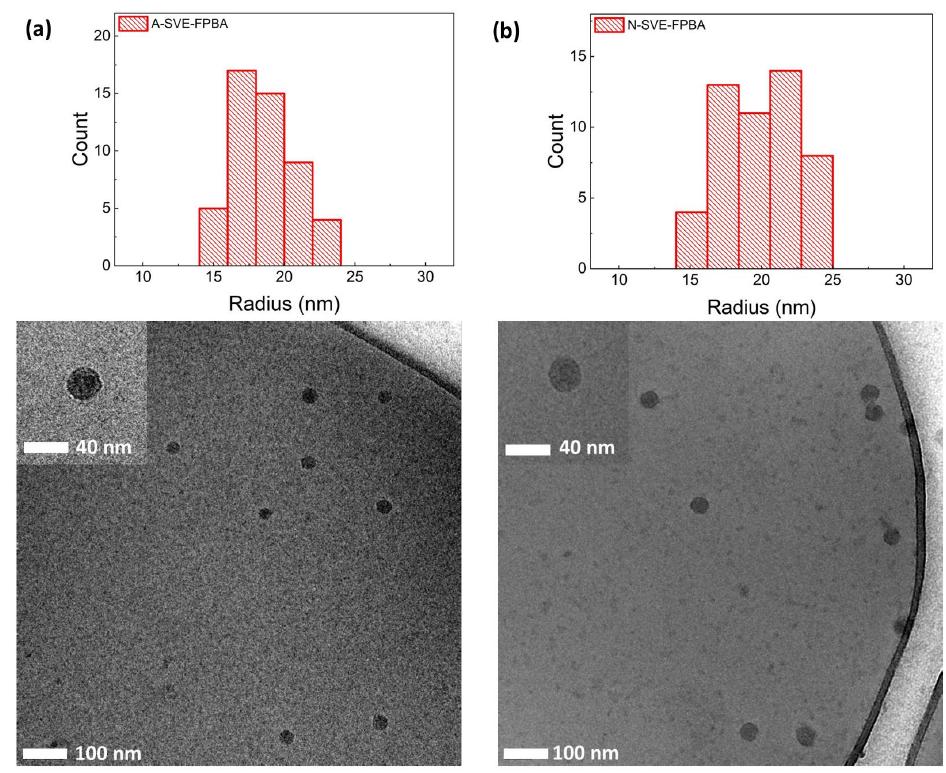
absorption spectrum, which allows for monitoring of AL binding into and releasing from